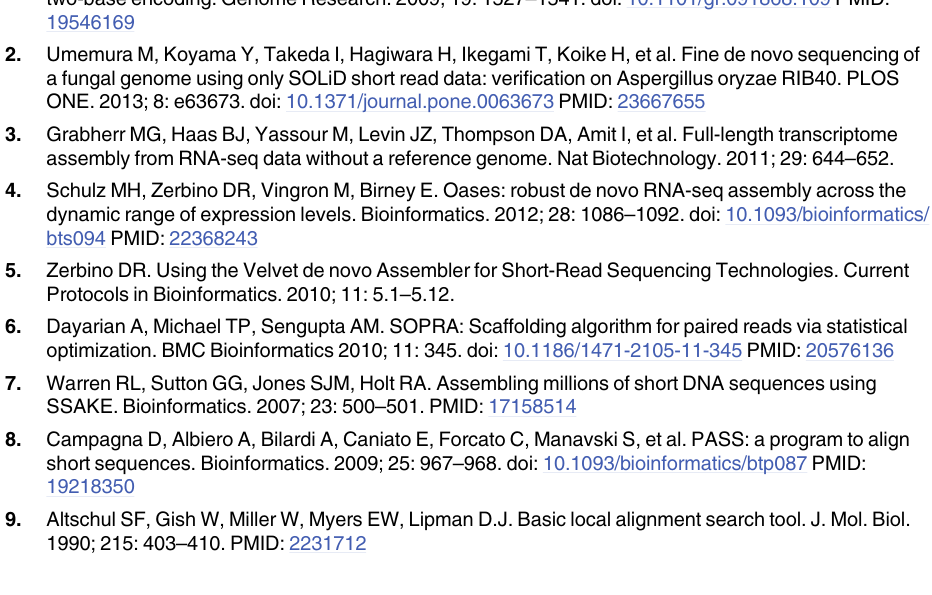
PLOS ONE | DOI:10.1371/journal.pone.0137436 September 14,